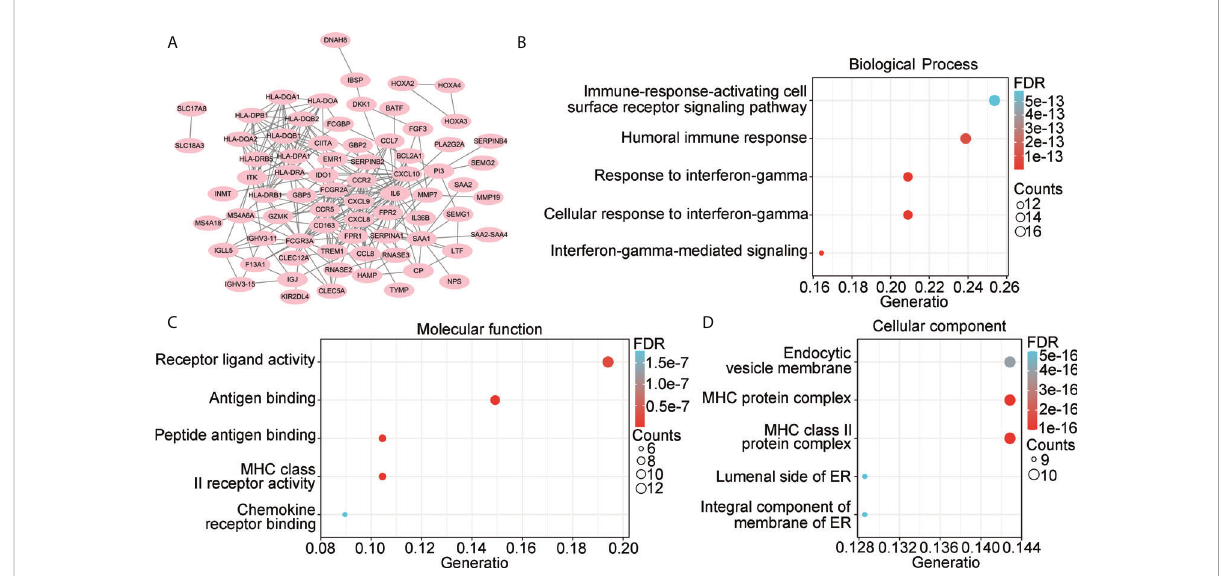
FIGURE 3 Landscape of 222 overlapping DEGs. (A) PPI network was constructed using 222 overlapping DEGs, while isolated genes were removed. Genes in PPI network were set as candidate hub genes. (B) Biological process (BP) analysis for candidate hub genes. (C) Molecular function (MF) analysis for candidate hub genes. (D) Cellular component (CC) analysis for candidate hub